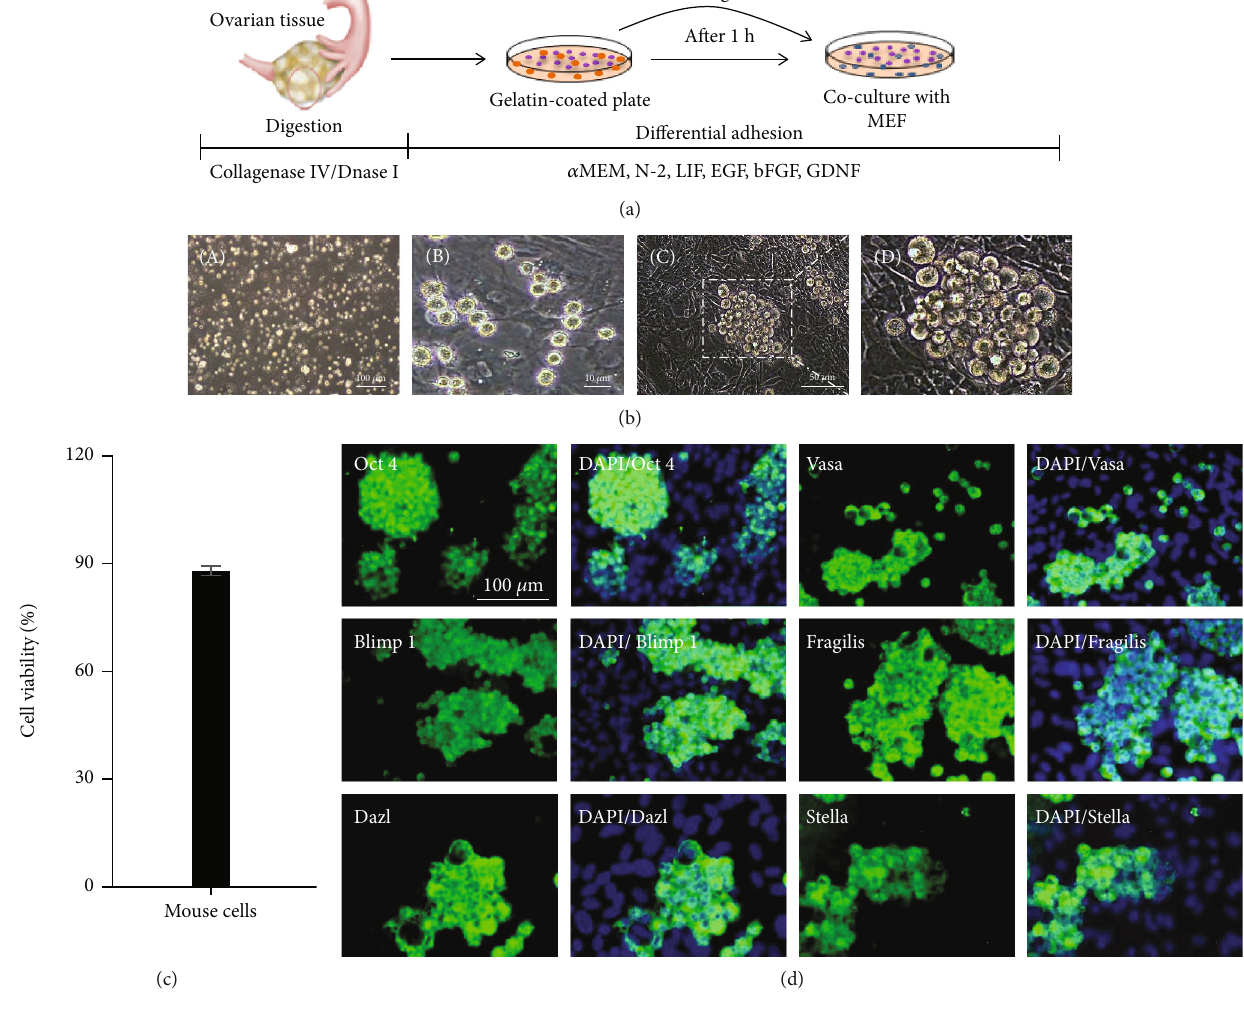
Figure 1: Isolation and culture of mouse female germline stem cells. (a) Schematic illustration of the culture system used for fGSC expansion. (b) Phase contrast images of mouse ovarian cell suspension after dissociation (A) and after 5 days of culture (B); spherical or grape-like clusters on day 30 in culture on MEF-coated plates (C, D; D at high magni fi cation). (c) Viability percentage of mouse ovarian cells after ovarian tissue isolation by using PI staining analyzed by a BD FACS Aria II. (d) Characterization of established fGSCs. Expression of germ cell-speci fi c markers in fGSCs detected by immunostaining analysis. The feeder cells were negative for these